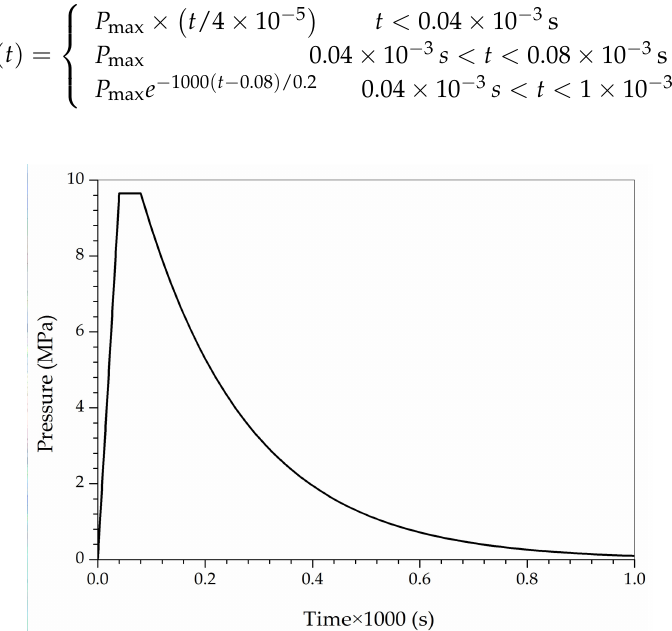
Figure 5. Pressure load distribution for the test